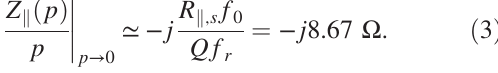
ð p Þ =p for the k